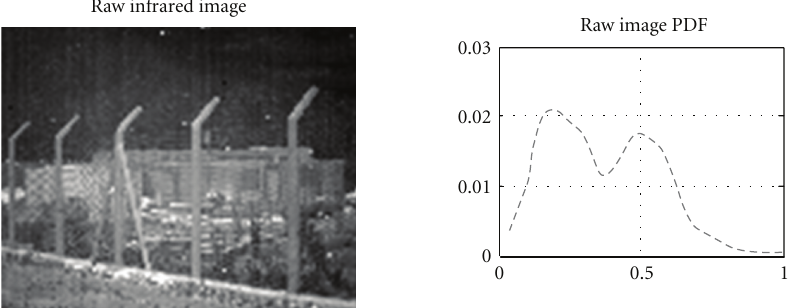
Figure 2: Raw infrared image and its associated PDF.